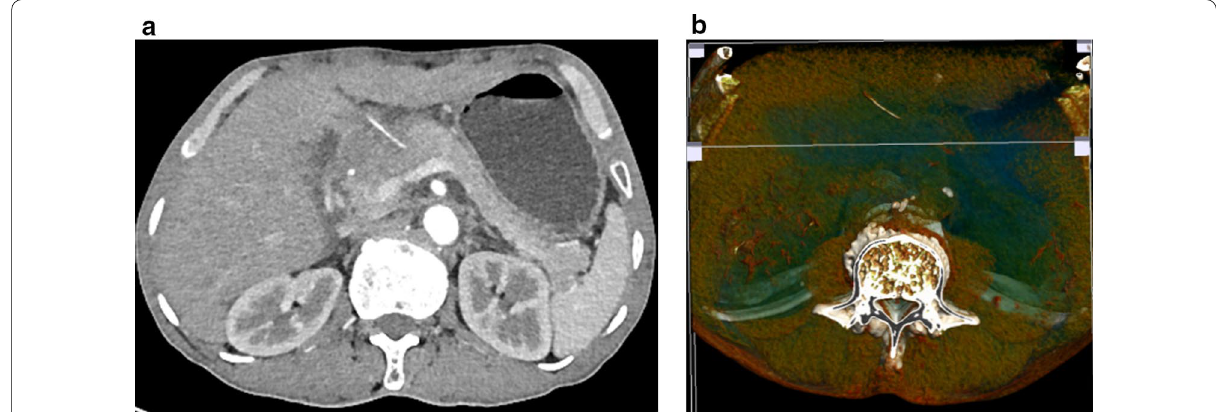
Fig. 1 a Computed tomography scan of the abdomen revealed a linear, hyperdense, foreign body along the stomach wall and pancreatic neck. b The bone condition CT clearly shows the position and shape of the fish bone in the abdominal